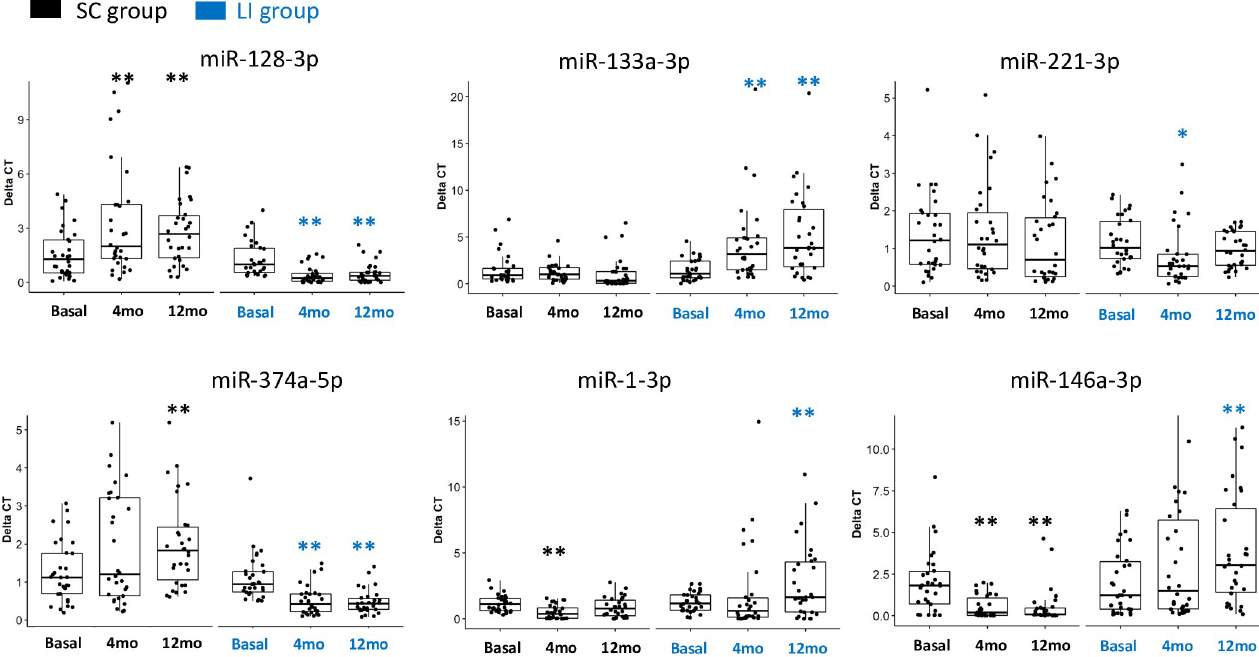
Fig 2. Expression of serum c-miRNAs significantly modulated by the 4 months LI protocol. Data are expressed as delta of Ct values inversely correlation with their blood concentrations. Gender and age were taken into account for the analyses.